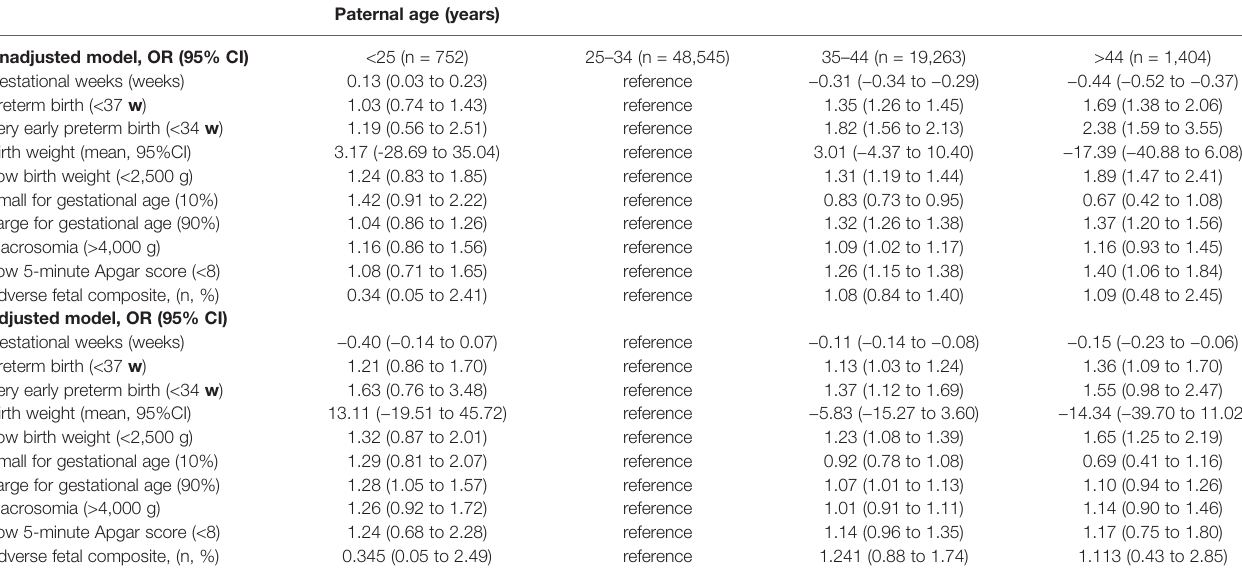
TABLE 2 | Unadjusted and adjusted risk of major outcomes strati fi ed by paternal age in 69,964 pregnancies.